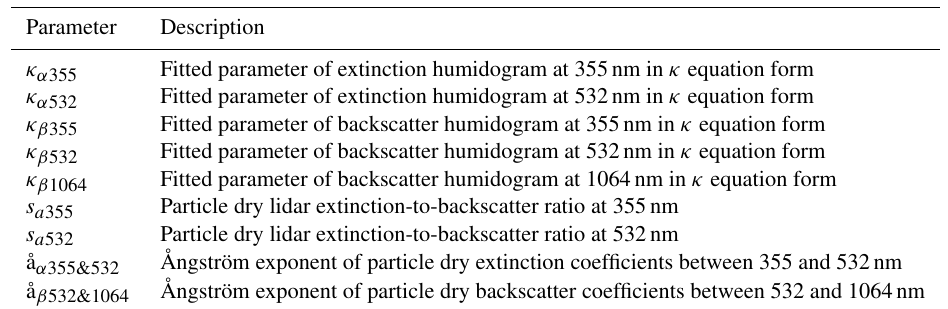
Table 4. Lidar-derived parameters for predicting optically related CCN activation ratio AR ξ .